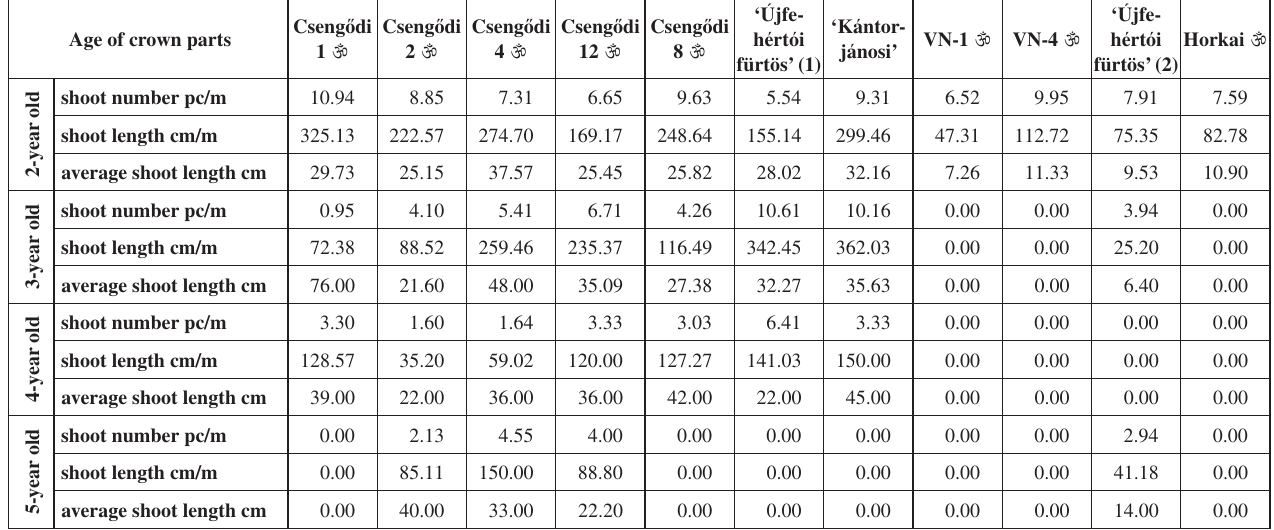
Table 5: Specific values of sour cherries on different aged canopy parts (Pallag and Újfehértó, 2013) Age of crown